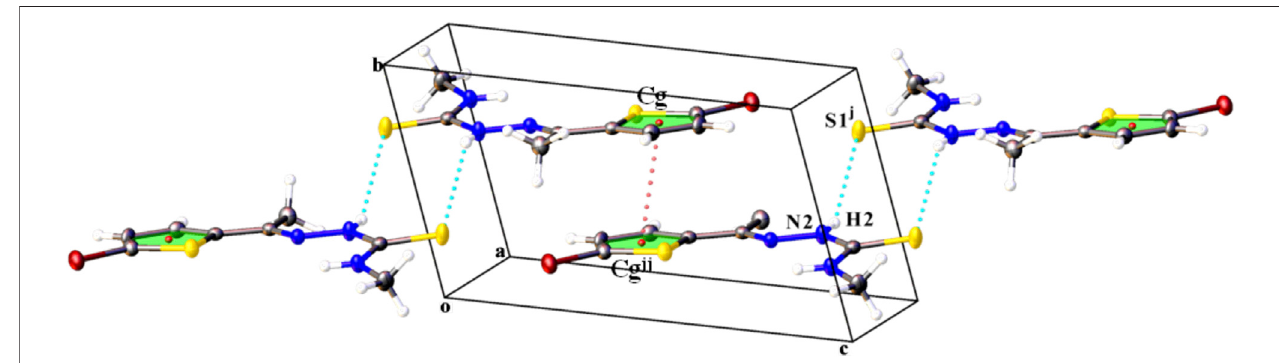
FIGURE 3 | Part of the crystal structure of compound L2 showing the formation of hydrogen-. bonded dimers running parallel to the ( 110 ) plane, and stacking of layers linked by π / π (thiophene ring) intermolecular interactions along the b axis. H atoms not involved in hydrogen bonding have been omitted for clarity. Symmetry